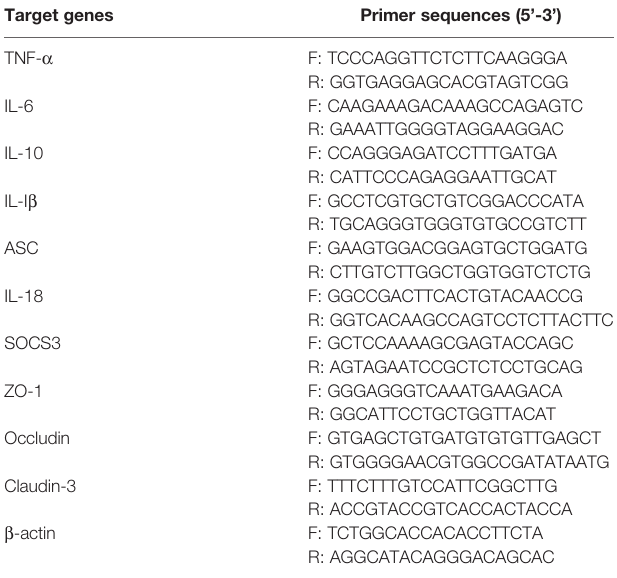
TABLE 1 | The primer sequences of the